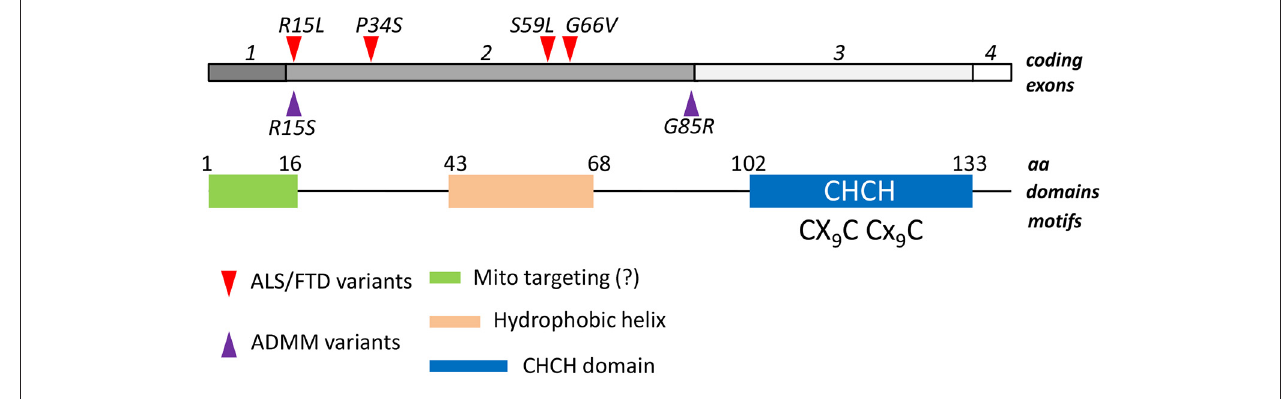
mitochondrial targeting sequence in the N-terminus, and a central hydrophobic helix have been also described. Mutations associated to ALS/FTD phenotypes (red triangles) and to Autosomal Dominant Mitochondrial Miopathy (ADMM, purple triangles) are reported. They all fall in the second